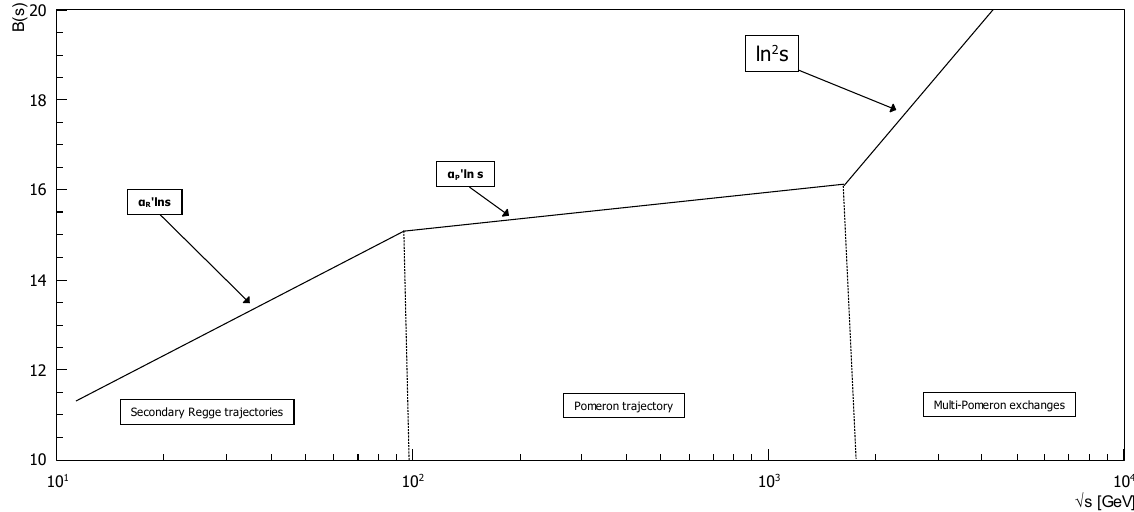
Figure 1. Three regimes of the energy dependence of the diffraction cone slope parameter B ( s ) in the Regge-pole model amended with contribution of multi–Pomeron exchanges in the LHC energy range. Quantitative justification for the second break can be found in